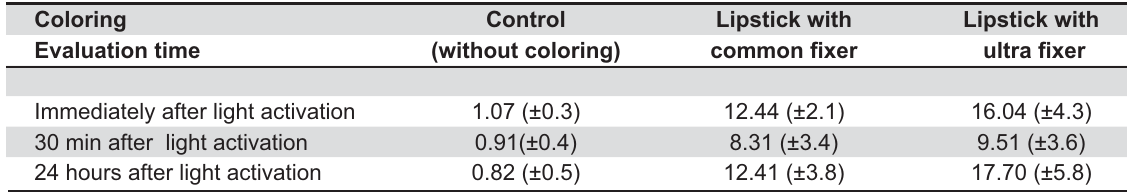
Table 1- (cid:11)(cid:17)(cid:10)(cid:6)(cid:26)(cid:11)$(cid:14)(cid:4)(cid:6)(cid:26)(cid:27)(cid:6)(cid:5)(cid:27)(cid:11)(cid:27)(cid:10)%(cid:12)(cid:6)(cid:4)(cid:12)(cid:19)(cid:26)&(cid:11)(cid:19)"(cid:11)*(cid:10)(cid:3)(cid:4)(cid:6)(cid:11)<(cid:11)$=<&(cid:11)%(cid:6)(cid:3)(cid:30)(cid:10)(cid:14)(cid:11)"(cid:19)(cid:5)(cid:11)(cid:6)(cid:3)(cid:3)(cid:11)(cid:26)(cid:12)(cid:26)(cid:10)(cid:11)(cid:10)(cid:9)(cid:13)(cid:10)(cid:5)(cid:12)(cid:21)(cid:10)(cid:26)(cid:4)(cid:6)(cid:3)(cid:11)>(cid:5)(cid:19)(cid:30)(cid:13)(cid:14)(cid:11)